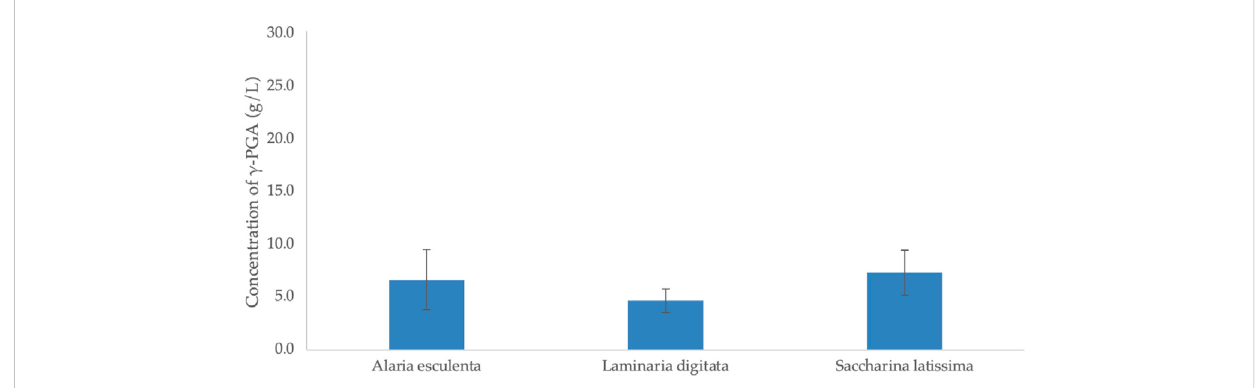
FIGURE 12 Average γ -PGA yields (PTF) obtained from supplemented Alaria esculenta or Laminaria digitata or Saccharina latissima cultivated in shake fl asks. Error bars indicate standard deviation of six timepoints during the year.